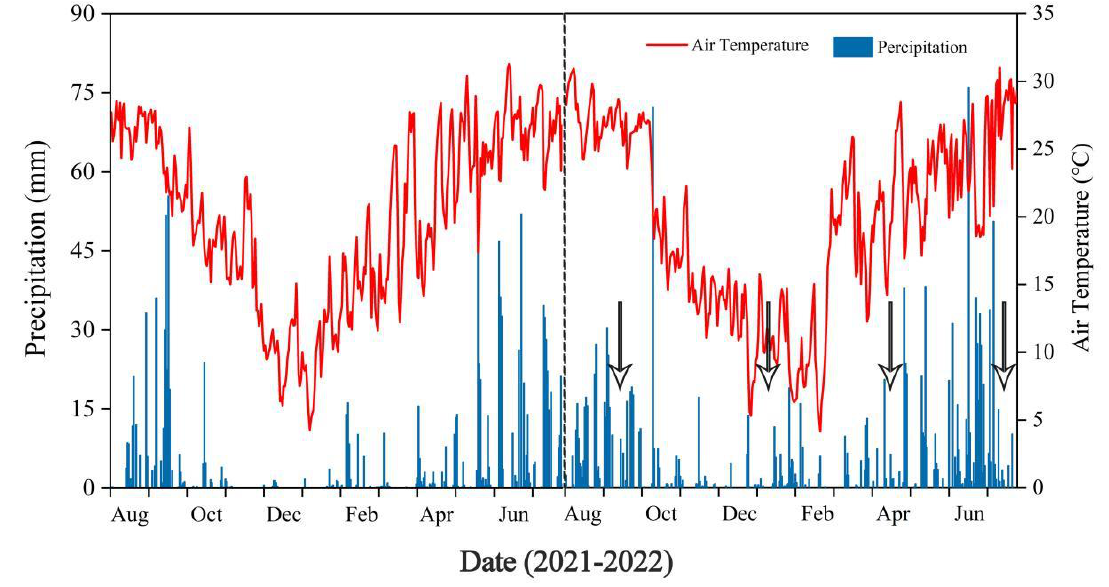
Figure 2. Precipitation and temperature in the study area from August 2020 to August 2022. The black arrow in the figure represents the sampling date.